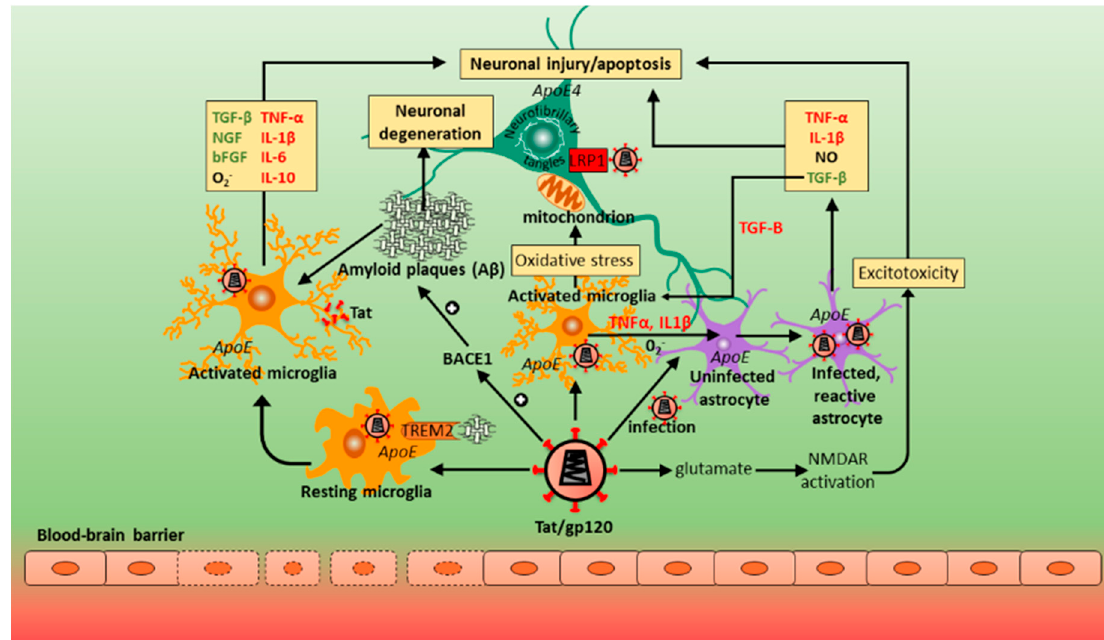
Figure 3. Common pathways in AD and HAND pathogenesis. In AD and HAND, there are several lines of attack that lead to neurodegeneration. β -amyloid aggregates not only have direct cytotoxic effects on neurons, but also indirectly through the generation and progression of a local neuroinflammation via activated and dystrophic resident glial cells in the vicinity of neurons. The latter, reactive gliosis, brings with its secretion of cytokines and chemokines that are released from microglia predominantly, and reactive astrocytes. The interaction between activated microglia and reactive and astrocytes is an important component of HAND pathogenesis. Secreted factors from microglia include members of the complement system (C1q, C3b, C4d, C5b-9), and pro-inflammatory cytokines TNF- α , and IL-1 β , IL-6, IL-10, whereas astrocytes release mainly TNF- α and IL-1 β . Enhanced secretion of TGF- β from reactive astrocytes favors activation of microglia. Further, TREM2 is highly expressed by microglia and alleviates pro-inflammatory factor-induced AD pathology by mediating phagocytosis of cell debris [233]. A β binds to and reduces TREM2 activity; dysregulation of TREM2 signaling contributes to the pathogenesis of both AD and HAND [234]. One interesting aspect is the release of reactive oxygen species (ROS) which can have multiple effects in this inflammatory process. For example, ROS can induce neuronal protein and lipid oxidation, DNA damage, and impair mitochondrial function by disturbing the oxidative respiratory chain, affecting neuronal transport processes and the ubiquitin-proteasome system. ROS, released from A β - stimulated microglia can also induce astrocytes to adopt a neurotoxic phenotype. The net result is the worsening of inflammation and brain damage. The HIV proteins Tat and gp120 activate NMDA receptors triggering excessive glutamate release and excitotoxicity. Tat also activates BACE1 promoting the formation of B-amyloid plaques, and enters neurons via LRP1 to prevent apoE4 uptake, amplifying neurotoxicity. Tat can also be synthesized and released in HIV-infected astrocytes; one source of infection is derived from activated microglia. ApoE4 is known to enhance HIV infection [151]. Neurons and microglia also secrete FGF and BDNF in an attempt to promote neuronal survival. Disease progression, however, results in the failure to repair the injured neurons. ( AD, Alzheimer’s Disease; HAND, HIV-associated neurocognitive disorder; TNF- α , tumor necrosis factor-alpha; IL-, interleukin; TGF- β , transforming growth factor beta; TREM2, membrane-bound triggering receptor expressed on myeloid cells 2; ROS, reactive oxygen species; Tat, transactivator of transcription; gp120, glycoprotein120; NMDA, N- methyl-D-aspartate; BACE1, beta-site amyloid-beta precursor protein cleaving enzyme 1; LRP1, low-density lipoprotein receptor-related protein 1; FGF, basic fibroblast growth factor; BDNF, brain-derived neurotrophic factor. ) Funding: This research received no external funding. Conflicts of Interest: The authors declare no conflicts of interest.